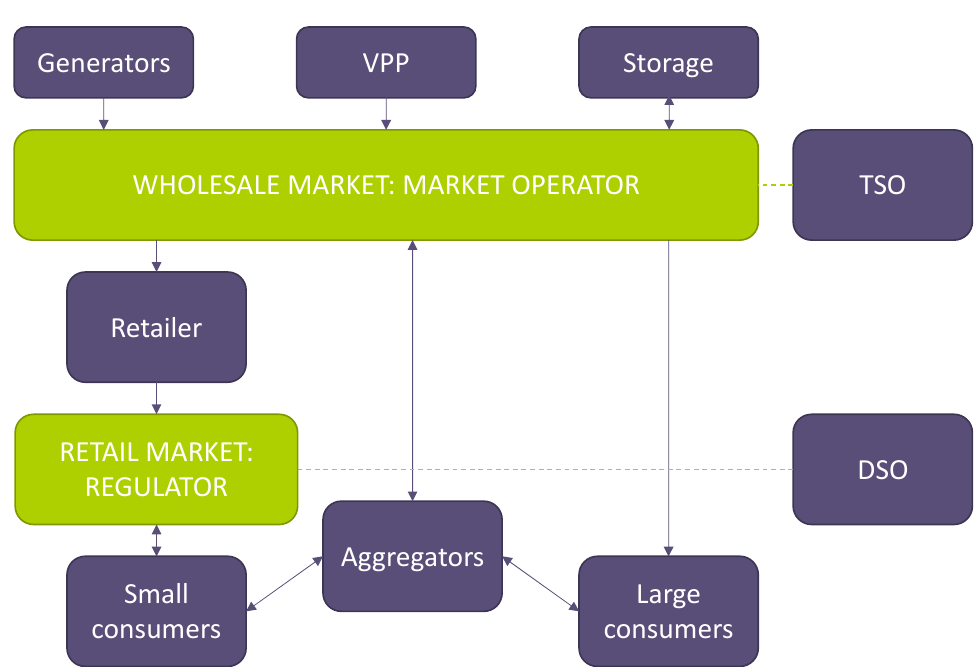
Figure 1. Electricity system agents overview. Note: VPP are Virtual Power Plants, TSO are Transmission System Operators, and DSO are Distribution System Operators.